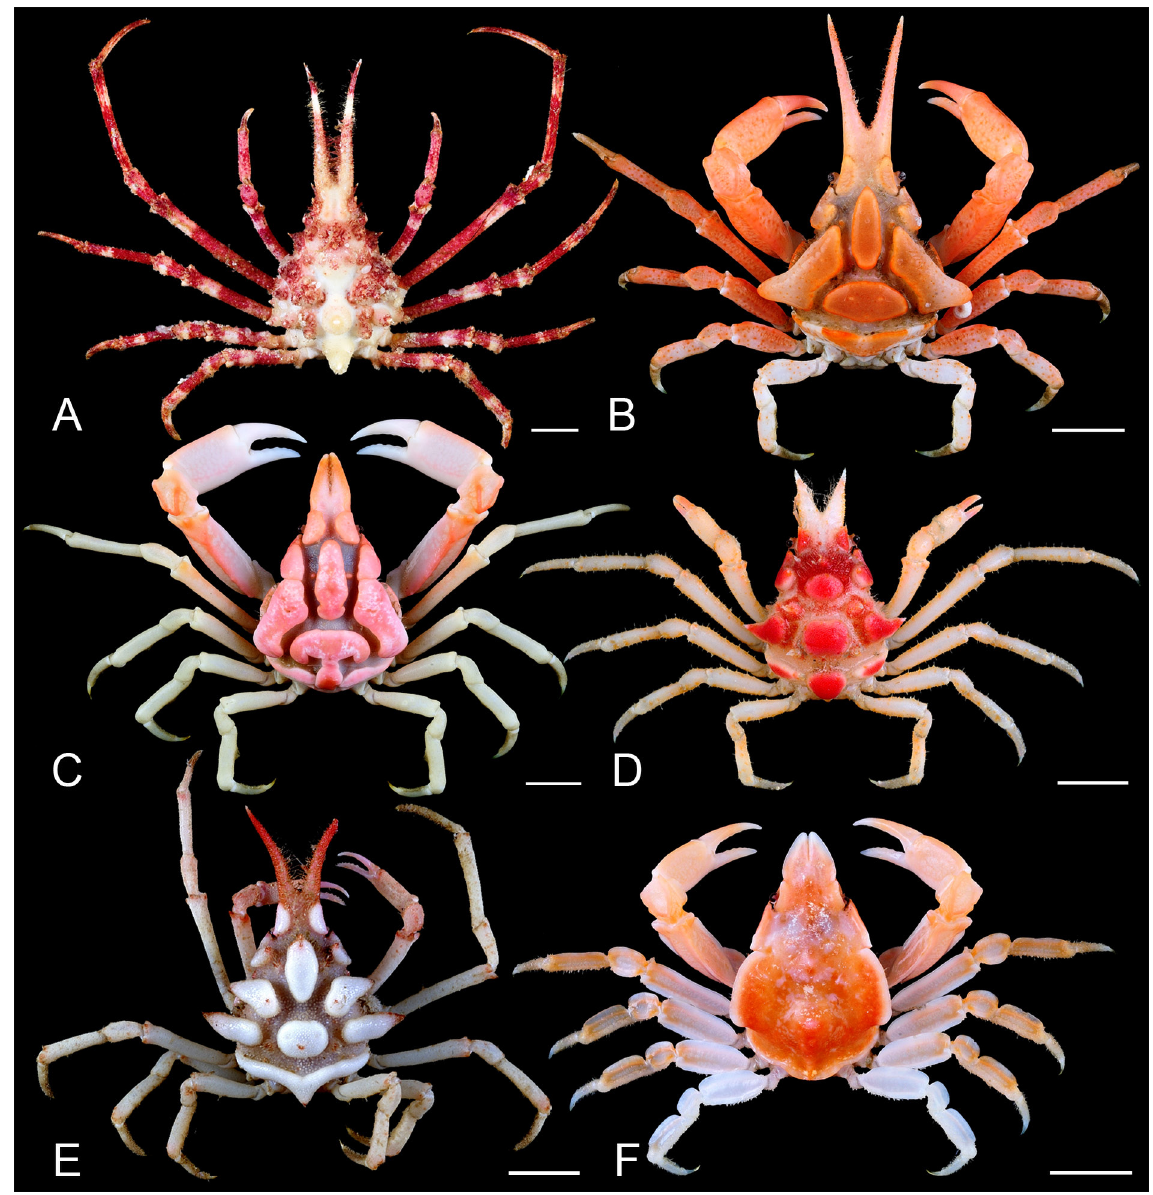
Fig. 13. Colour in life. A . Naxioides robillardi (Miers, 1882), ♂ (39.2 × 24.5 mm) (ZRC 2016.01065), South China Sea. B . Oxypleurodon stimpsoni Miers, 1885, ♂ (with Sacculina , 14.0 × 9.0 mm) (ZRC 2016.0072), South China Sea. C . Oxypleurodon auritum (Rathbun, 1916), ♂ (16.7 × 11.1 mm) (ZRC 2016.0066), South China Sea. D . Oxypleurodon forte Lee, Corbari & Richer de Forges, 2015, ♂ (14.2 × 9.1 mm) (ZRC 2016.0078), South China Sea. E . Oxypleurodon sanctaeclausi Richer de Forges & Ng 2009, paratype, ♀ (18.7 × 16.8 mm) (ZRC 2009.0019) (after Richer de Forges & Ng 2009a). F . Stegopleurodon pteridion sp. nov., holotype, ♂ (13.1 × 7.9 mm) (NTOU), South China Sea. Scale bars: A = 10 mm; B–F = 5